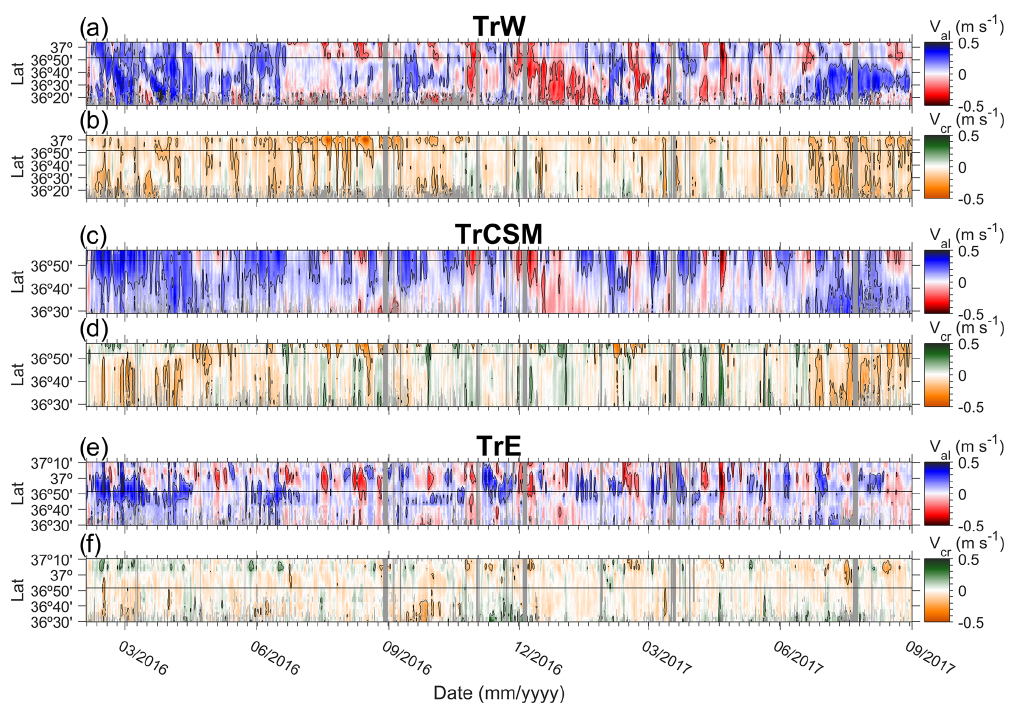
Figure 8. Hovmöller diagram of V al (a, c, e) and V cr (b, d, f) extracted at transects TrW, TrCSM and TrE, from 3 February 2016 to 1 September 2017. Equatorward and poleward velocities are represented in blue and red, respectively; onshore and offshore velocities are represented in green and orange, respectively. Black contours indicate ± 0.15ms − 1 . The 200m isobath is indicated as a black horizontal line. Major ticks on x axes represent the first day of the indicated month, and minor ticks represent 1-week intervals.